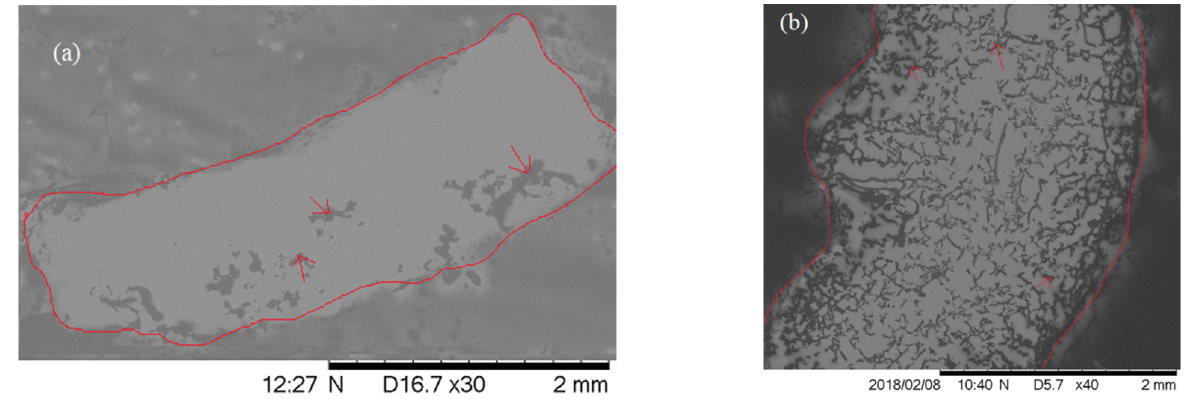
Figure 6. Cross-sectional images of the ( a ) PEGDA-PCL and ( b ) SA-PCL hydrogels. The red line shows the boundary between embedding media and scaffold. The histology section thickness for both samples was 5 microns. Each image was captured 30 × magnification. The arrows show the presence of voids.